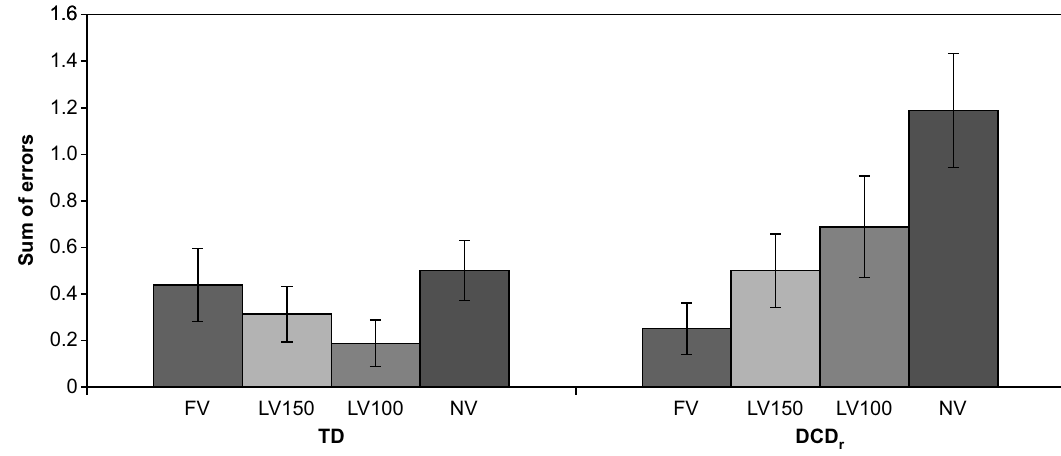
Figure 2. Means of sum of errors in different groups and visual conditions. Error bars represent standard errors of the mean. TD = typically developing, DCD disorder. FV = full vision, LV150 = limited vision 150, LV100 = limited vision 100, NV = non